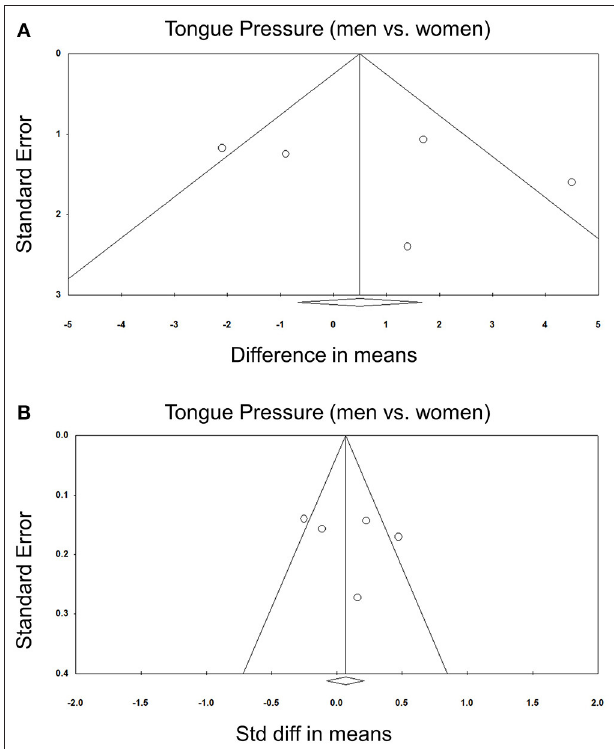
FIGURE 7 | Funnel plot of the weighted mean difference (A) and standardized mean differences (B) of the tongue pressure between men and women among the included studies. Std diff, standardized